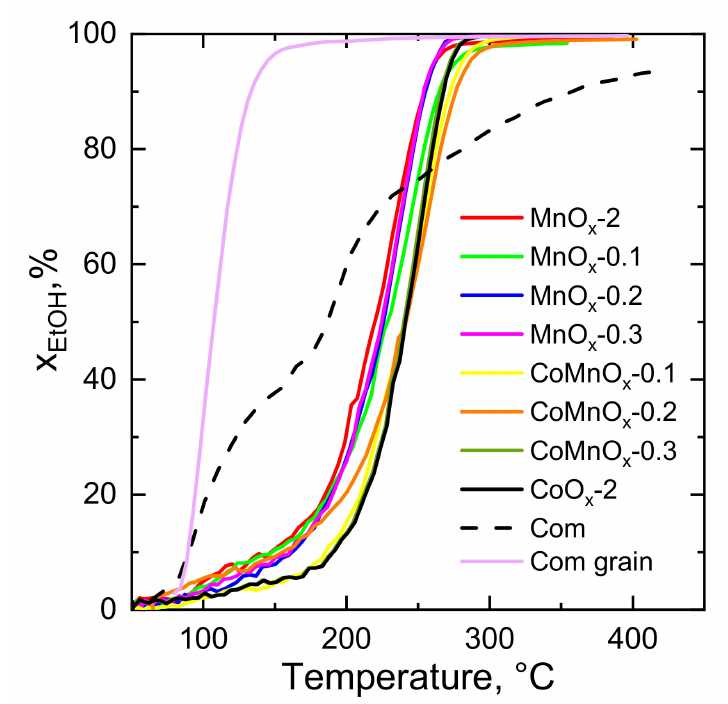
Figure 7. Dependence of ethanol conversion on the reaction temperature for the investigated catalysts in the form of meshes and of Com catalyst in the form of pellets and